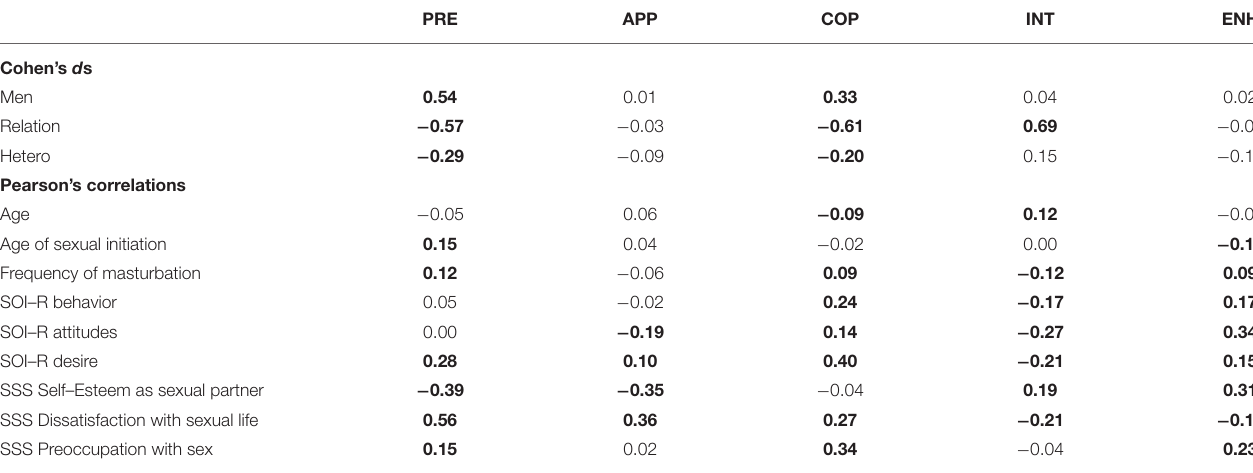
TABLE 3 | Associations of the different sexual